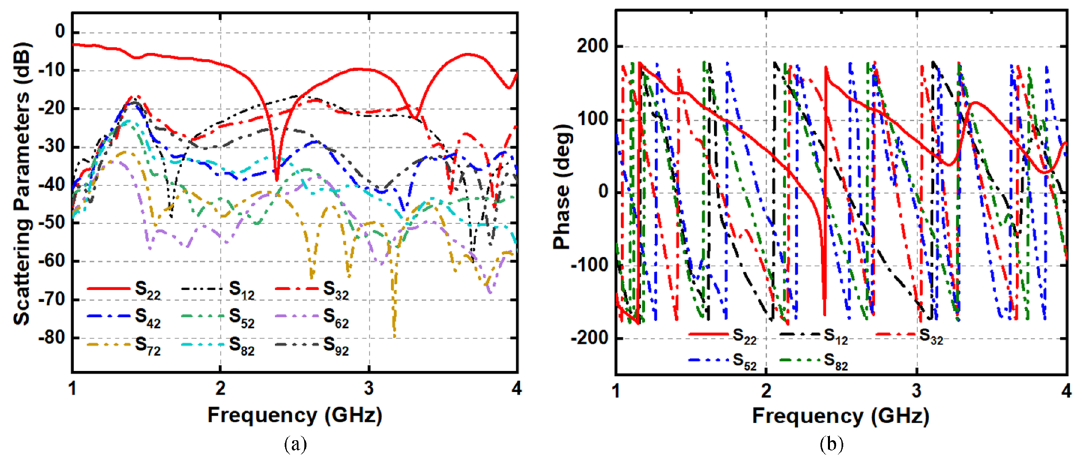
Figure 21. Sample ( a ) scattering parameters and ( b ) phase (antenna 2: